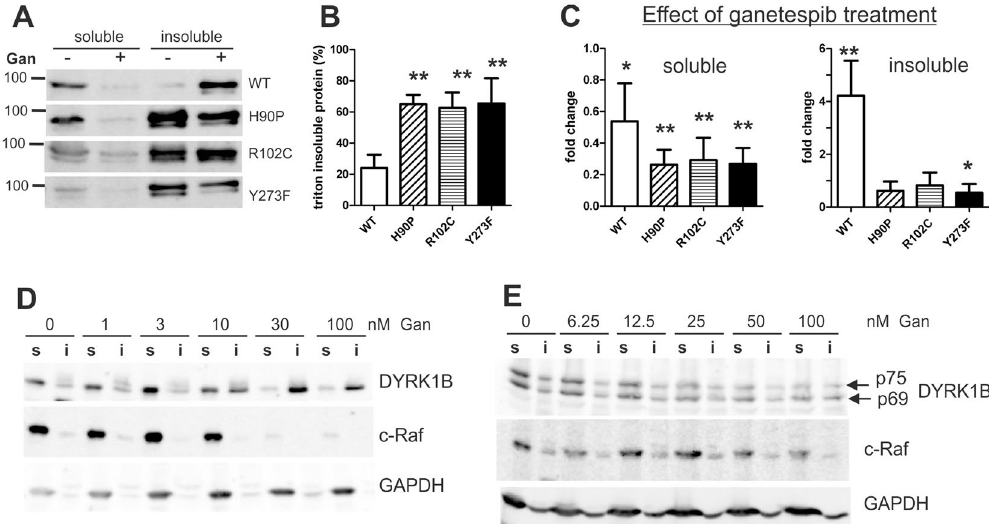
Figure 7. Effect of ganetespib on the aggregation of DYRK1B. ( A – C ) Effect on wild type and mutant GFP- DYRK1B. HeLa cells transiently expressing the indicated GFP-DYRK1B constructs were treated with 100 nM ganetespib for 24 h and then lysed with 0.1% Triton X-100, followed by separation of the soluble and insoluble fractions. Equivalent aliquots of the samples were subjected to Western blot analysis with a DYRK1B specific antiserum. Panel A shows the Western blots of a representative experiment. Blots from n = 5 independent experiments were densitometrically evaluated to determine the percentage of triton-insoluble protein in untreated cells (panel B) and the ganetespib-induced changes of GFP-DYRK1B levels (panel C). Significant differences between WT and mutant DYRK1B (panel B, two-tailed t-test) or treated and untreated cells (panel C, One sample t-test) are marked ( * p < 0.05; ** p < 0.01). ( D , E ) Concentration-response relationship of the ganetespib effect. Cells treated with increasing concentrations of ganetespib for 24 h before lysis with Igepal CA-630 containing buffer and fractionation. Western blots were developed with antibodies for DYRK1B, c-Raf as a known HSP90 client 42 , and GAPDH as a control for a HSP90-independent, stable protein. Relative to the soluble fraction, a 3-fold larger aliquot of the insoluble fraction was loaded on to the gel. In panel D, HeLa cells were transfected with untagged DYRK1B. Panel E shows untransfected RINm5F insulinoma cells. DYRK1B splicing variants were identified by co-migration with recombinant proteins (see uncropped blots). Blots are representative of 3